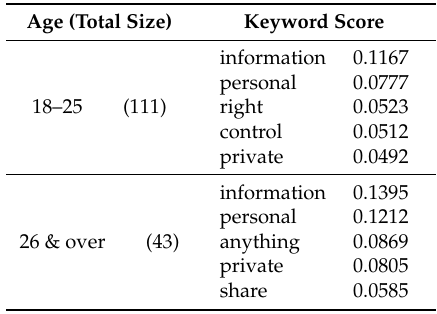
Table 6. Top words used to define privacy using TF-IDF Scores for each document via age demographic. This table includes the cluster label and the top five words by the highest TF-IDF